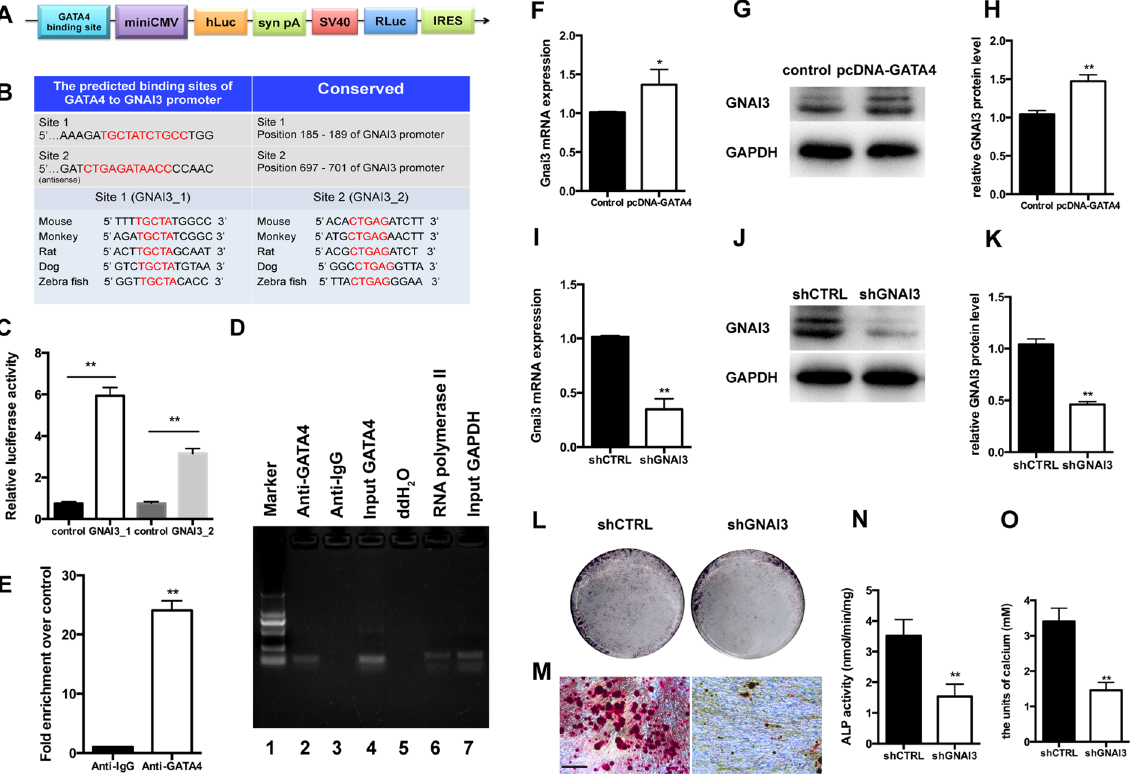
Figure 8. Regulation of GNAI3 expression by GATA4. ( A ) Schematic diagram of the Dual-Luciferase reporter vector (pEZX-FR03); ( B ) By computational target prediction analysis, we selected two binding sites for further research. The matched sequence of GATA4 to GNAI3 promoter was acquired from the JASPAR database. The binding site sequence that is highly conserved (red fonts) in several species; ( C ) Quantitative results of dual- luciferase reporter assay. ( D ) ChIP gel shift assay and quantitative PCR for GATA4 binding to GNAI3 promoter in SCAPs. Lane 1, DNA marker; Lane 2, ChIP sample with GATA4 antibody; Lane 3, ChIP sample with lgG antibody; Lane 4 Input amplified by GATA4 primers; Lane 5, ddH2O amplified by GATA4 primers; Lane 6, ChIP sample with RNA polymerase II antibody; Lane 7, Input amplified by GAPDH primers. ( E ) Primers were designed to cover the GNAI3 promoter region and used to identify the binding sites of GATA4 by ChIP assay. Relative enrichment of the binding sites of GATA4 was observed in SCAPs on qRT-PCR. qRT-PCR ( F ) assay and western blotting ( G , H ) were conducted to examine the expression of GNAI3 after GATA4 over-expression. The efficiency of GNAI3 knockdown was analyzed by qRT-PCR ( I ) and western blotting ( J , K ). ALP staining ( L ) was examined and activity of ALP ( N ) was analyzed by ALP activity assay kit after 5-days of osteogenic induction; ( M , O ) ARS staining was performed and quantified using a microplate reader at 562 nm (Bar: 100 μ m). Data expressed as mean ± Standard Deviation, n = 3. * P < 0.05; ** P <